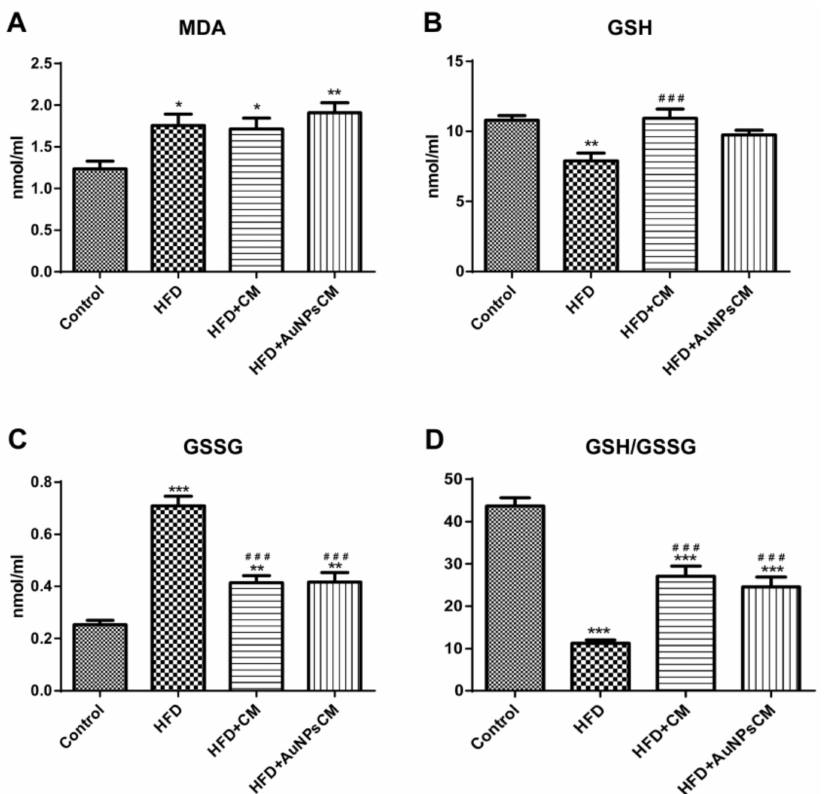
Figure 14. The serum oxidative stress parameters after 9 months of HFD, the last month with oral ad- ministration of: 0.9% saline solution for Control and HFD groups, Cornus mas L. extract for HFD + CM group and gold nanoparticles functionalized with bioactive compounds from Cornus mas L. extract for HFD + AuNPsCM group: malondialdhyde (MDA) ( A ), reduced glutathione (GSH) ( B ), oxidized glutathione (GSSG) ( C ) and ratio GSH/GSSG ( D ) (* compared to Control group, # compared to HFD group). The results were statistically analyzed by one-way ANOVA followed by the Post-test Tukey, using GraphPad Prism version 5.03 software (GraphPad, San Diego, CA, USA). The parameters were expressed as means ± SD (* p < 0.05, ** p < 0.01, *** p < 0.001 compared to Control group; ### p < 0.001 compared to HFD